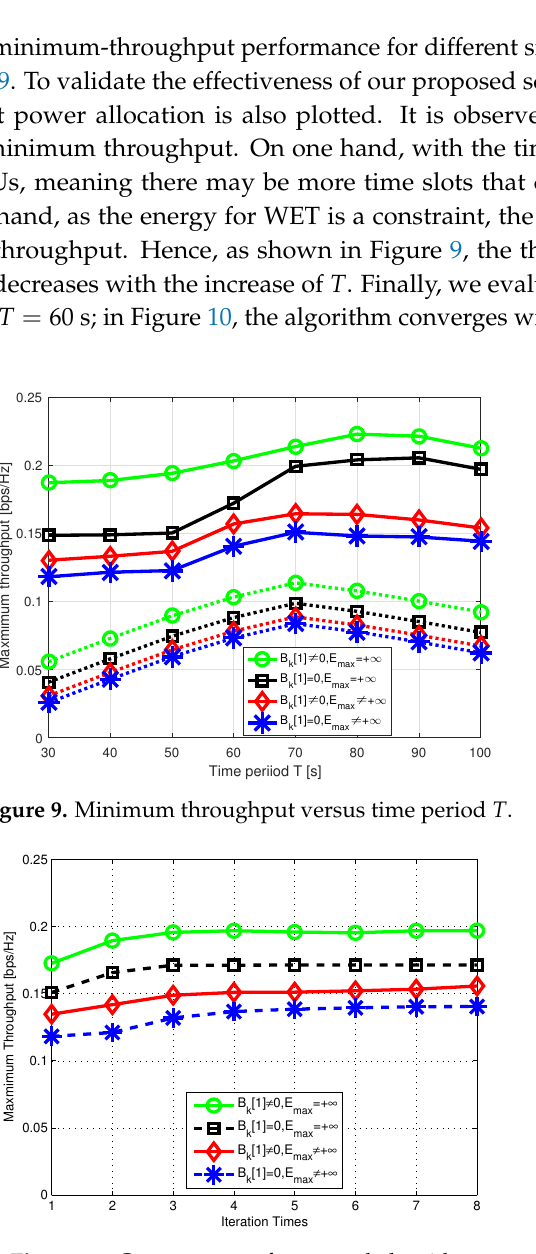
Figure 10. Convergence of proposed